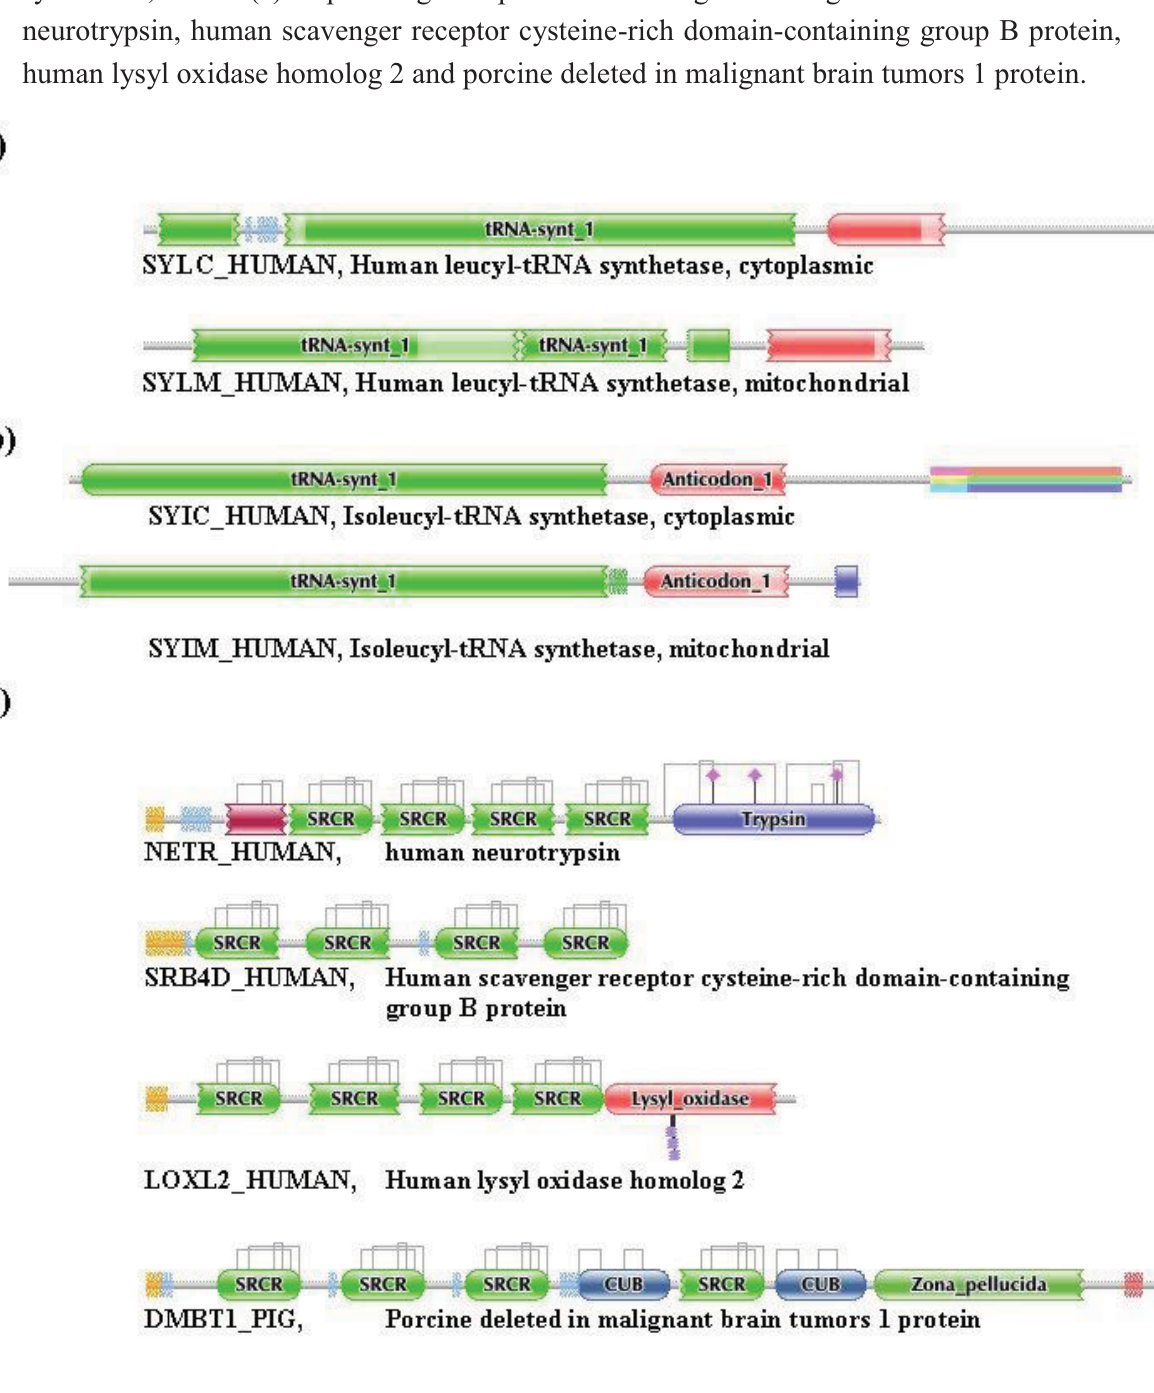
Figure 2. Types of homology of multidomain proteins: pseudoparalogs and epaktologs. ( a ) Pseudoparalogous multidomain proteins with identical DA — cytoplasmic and mitochondrial Leucyl-tRNA synthetase; ( b ) Pseudoparalogous multidomain proteins with different DA — cytoplasmic Leucyl-tRNA synthetase and mitochondrial Isoleucyl-tRNA synthetase; and ( c ) Epaktologous proteins sharing homologous domains —